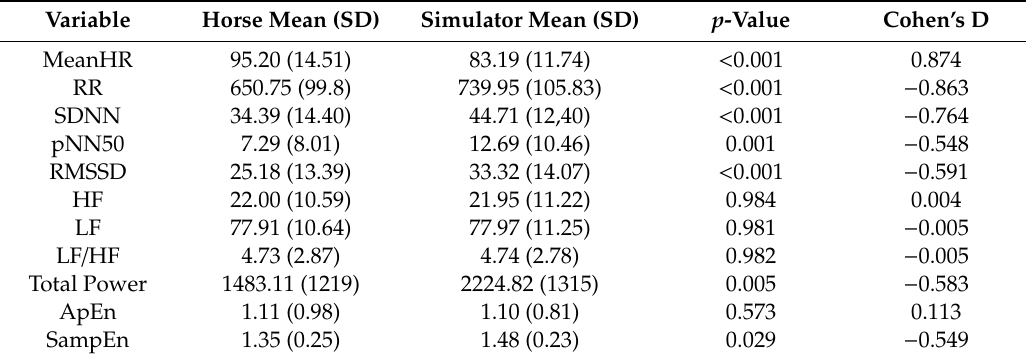
Table 1. Heart rate variability values during the horse riding and the horse simulator riding.